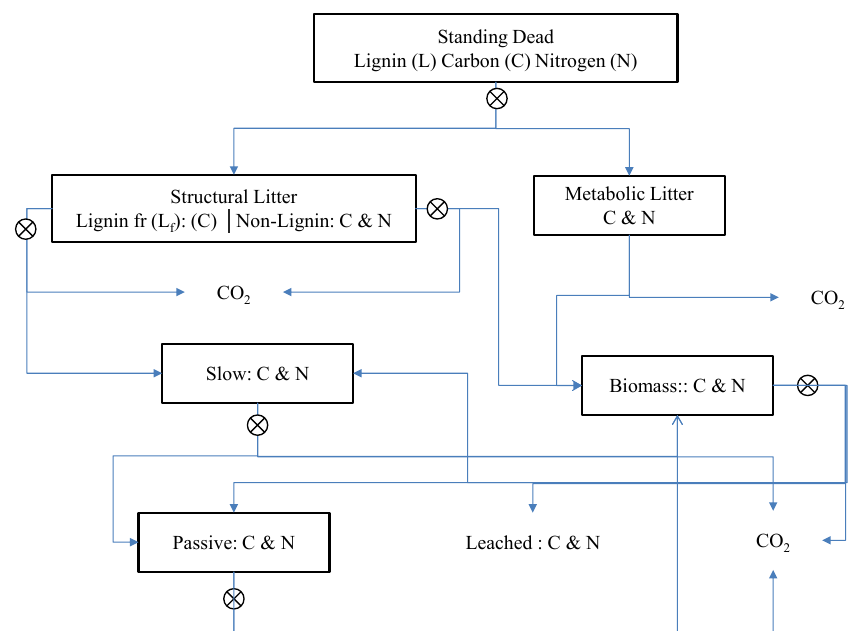
Figure 1. Carbon (C) and nitrogen (N) pools in APEX/EPIC (redrawn from Izaurralde, et al. [12]).